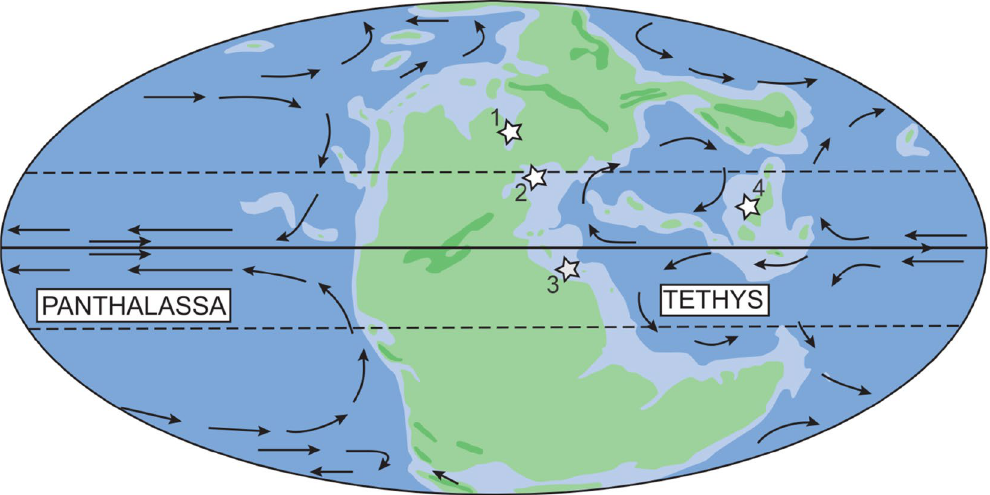
Figure 5. Palaeogeographic map showing the location of (1) Svalbard, (2) Italy & Hungary, (3) Oman, and (4) South China during the Permian/Triassic boundary. Base map from Golonka 58 and interpreted oceanic currents from Flügel 59